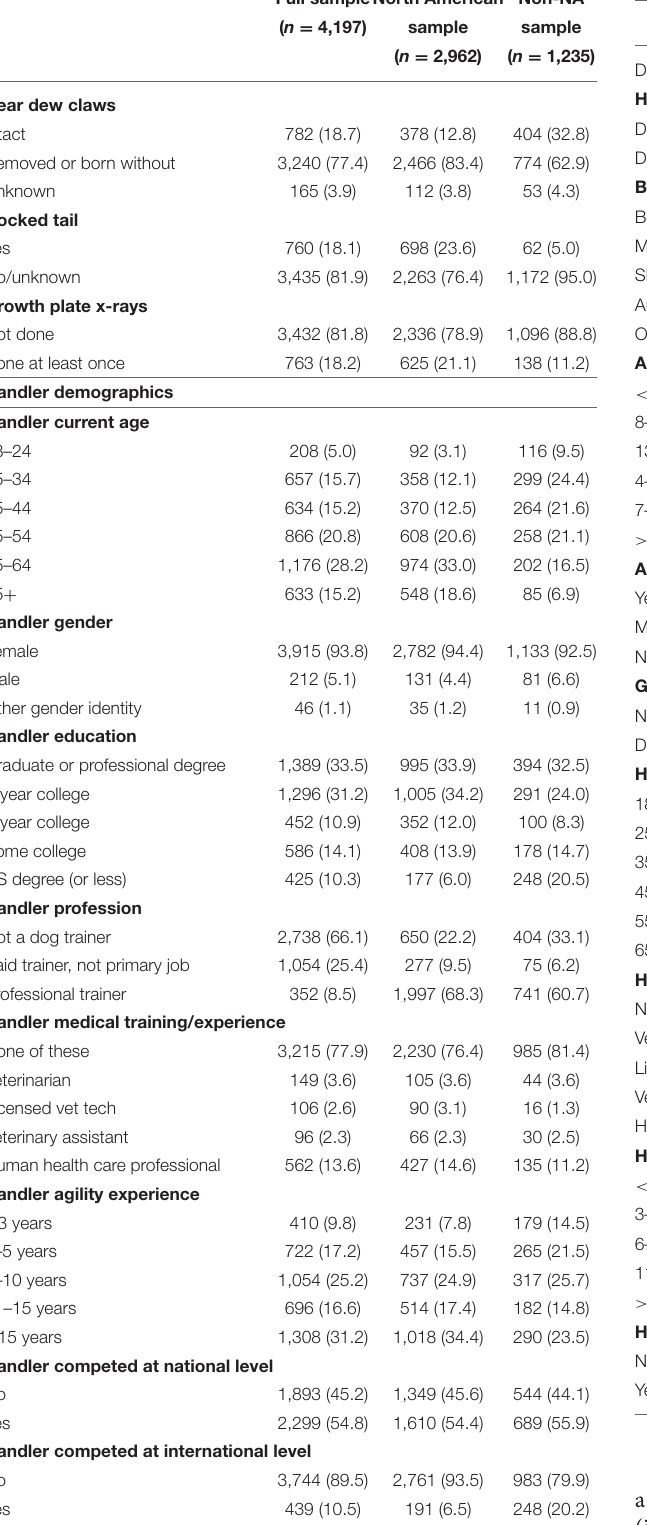
TABLE 2 | Coefficients from final adjusted model of risk factors of any injury using the full